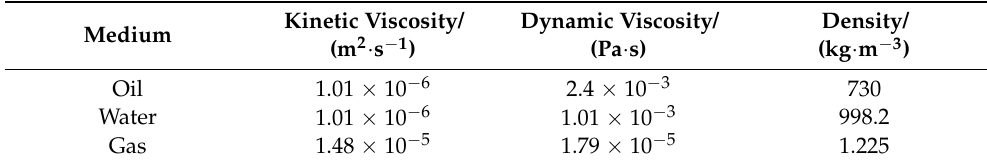
Table 1. Boundary conditions of the numerical model. Table 2. Physical parameters of fluid